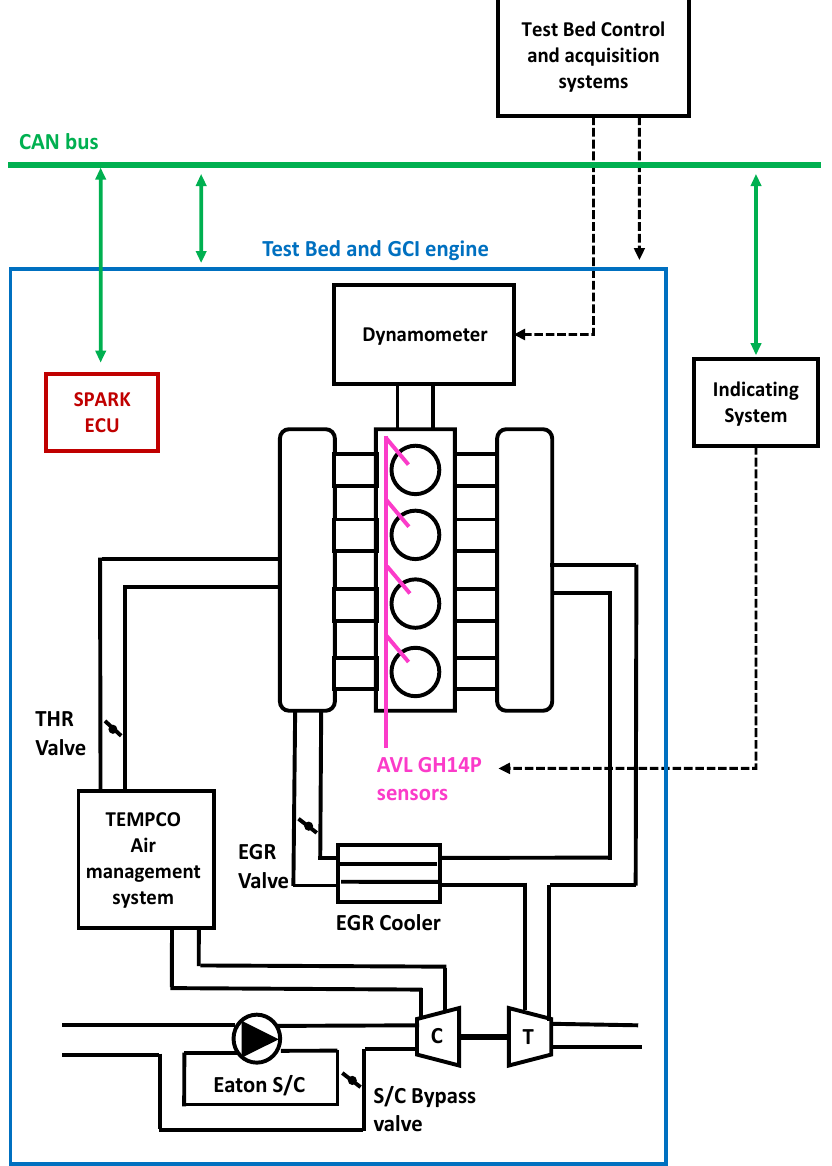
Figure 1. Scheme of the developed GCI engine and control system layout.